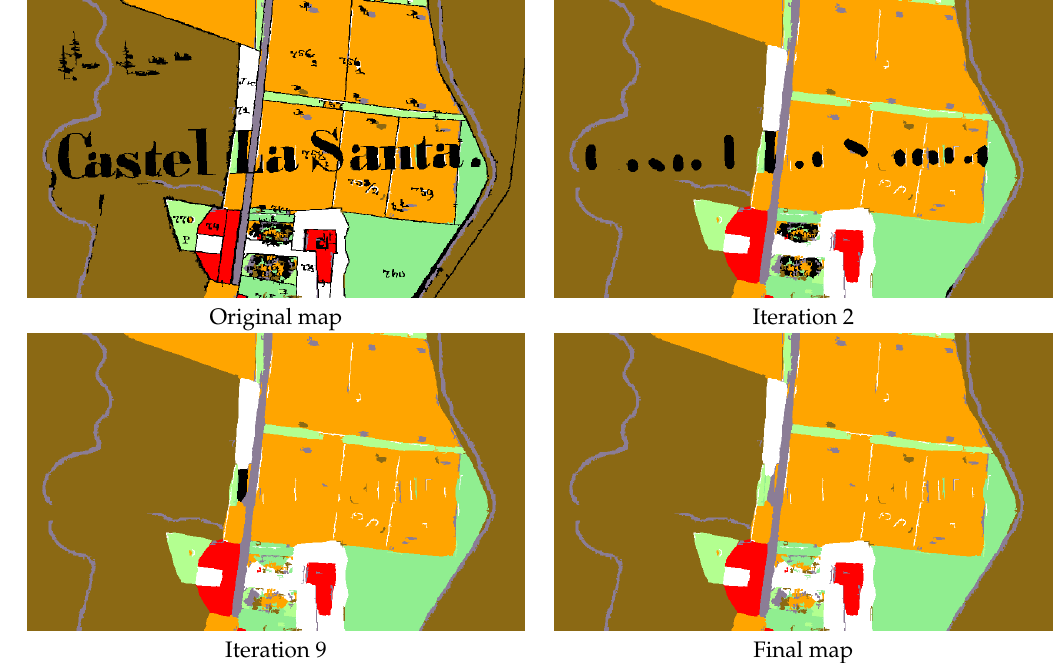
Figure 12. Text, symbol and lines removal with 23 × 23 filter: original map, map after two and nine iterations and the final map, with all text, symbols and lines removed, after 24